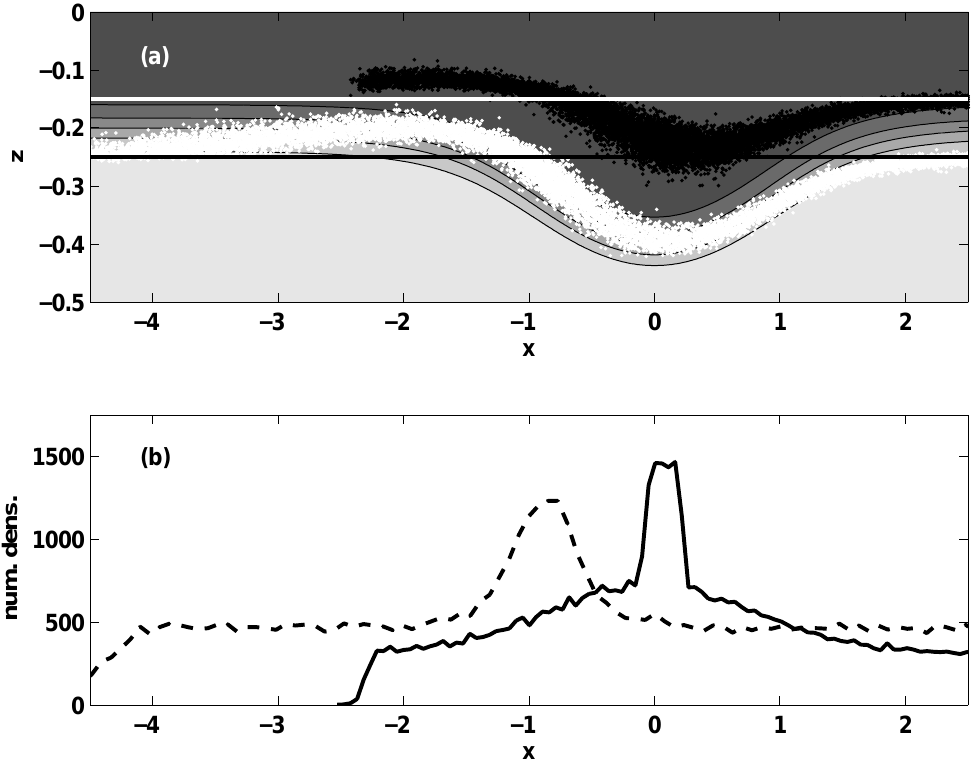
Fig. 8. Quasi-steady state particle distribution for particles with return to equilibrium photic level swimming. (a) particle clouds, z l =− 0 . 15 black, z l =− 0 . 25 white, five isopycnals are shaded. (b) number density z l =− 0 . 15 solid, z l =− 0 . 25